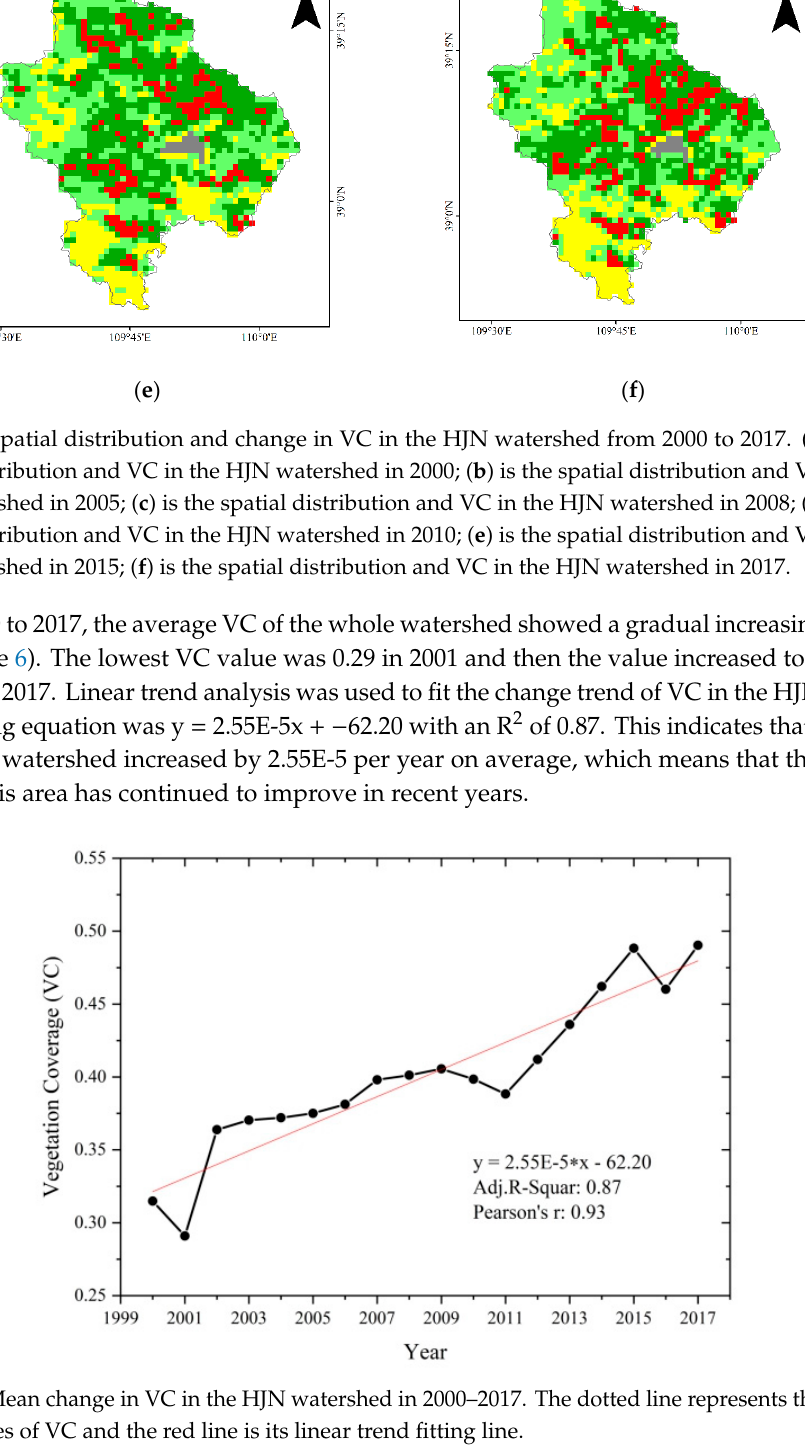
Figure 5. Spatial distribution and change in VC in the HJN watershed from 2000 to 2017. ( a ) is the spatial distribution and VC in the HJN watershed in 2000; ( b ) is the spatial distribution and VC in the HJN watershed in 2005; ( c ) is the spatial distribution and VC in the HJN watershed in 2008; ( d ) is the spatial distribution and VC in the HJN watershed in 2010; ( e ) is the spatial distribution and VC in the